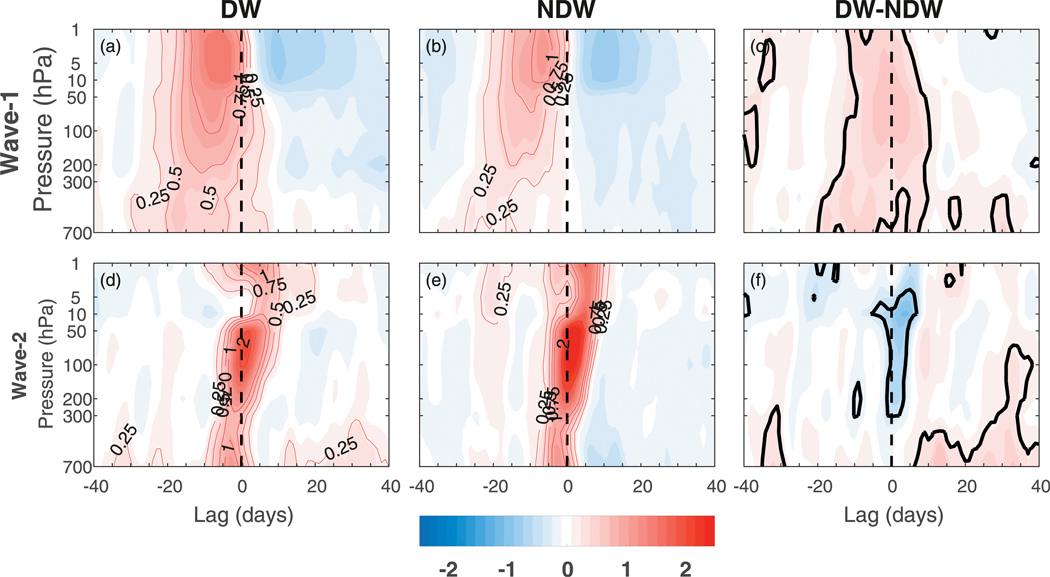
As in Fig. 13, but for split SSW events